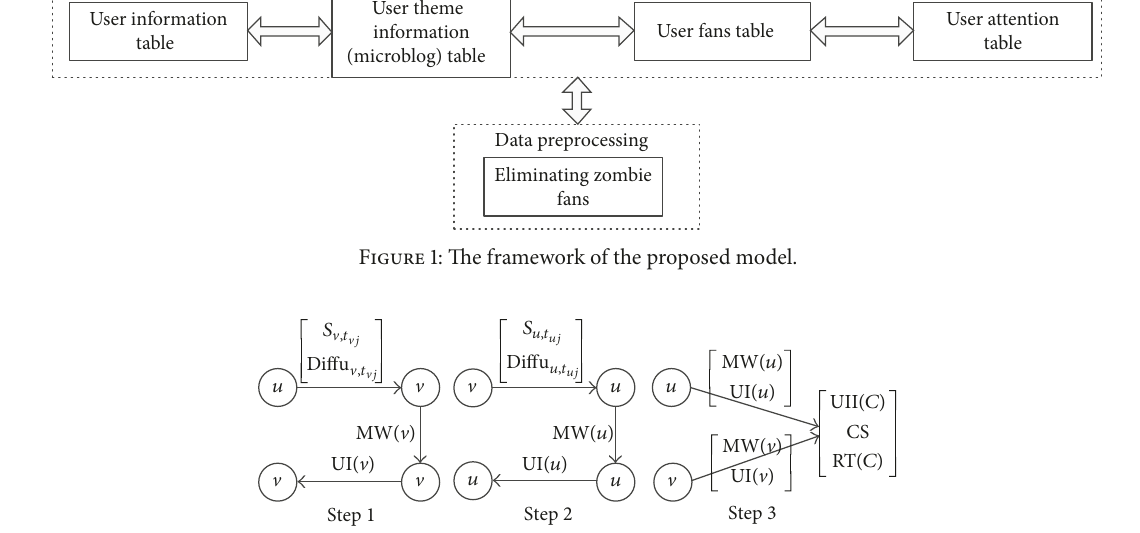
Figure 2: The working steps of the community-level influence analysis